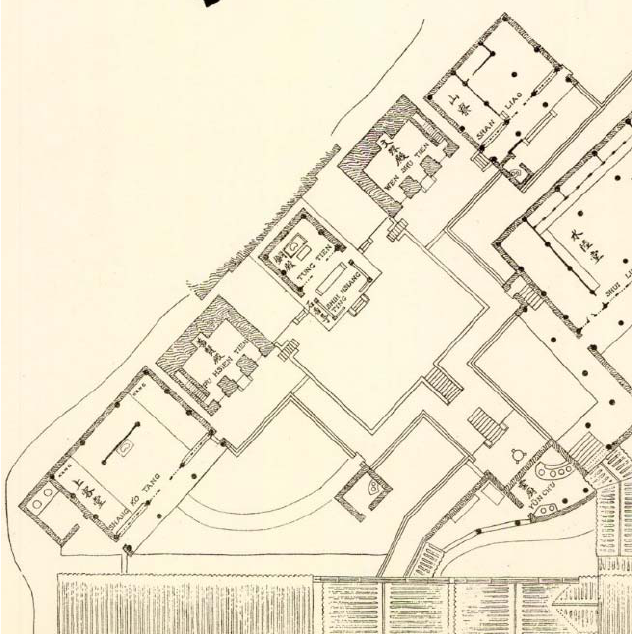
Figure 17. Detail of the third floor plan of Longchang Monastery, showing the Open ‐ Air Platform Unit in the upper half, the Roofs of the Ordination Platform Unit in the bottom ‐ left, and the roofs of a corner of the Main Courtyard in the bottom right (Prip ‐ Møller 1937, Pl. 3).